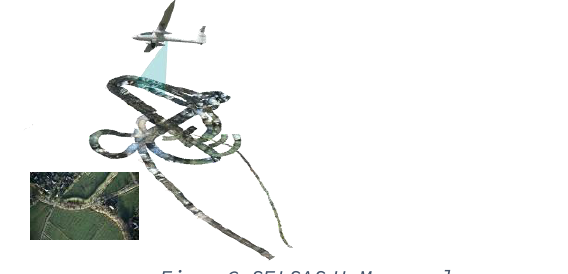
Figure 6: SELSAS-HyM example